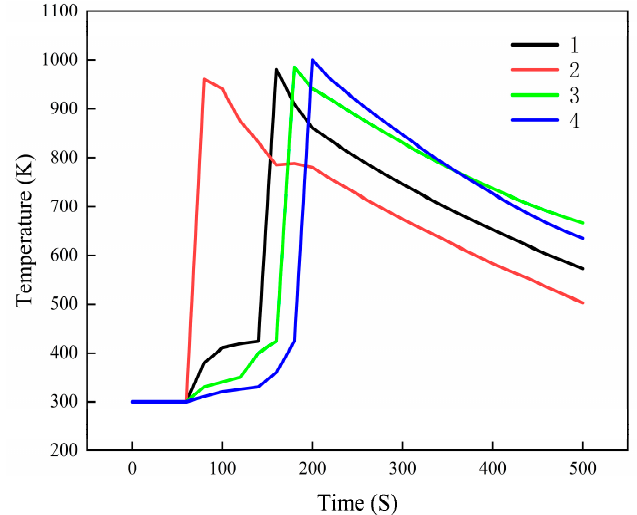
Figure 13. The maximum body temperature of each battery in scheme A under the condition of TR (when setting No. 2 battery TR).